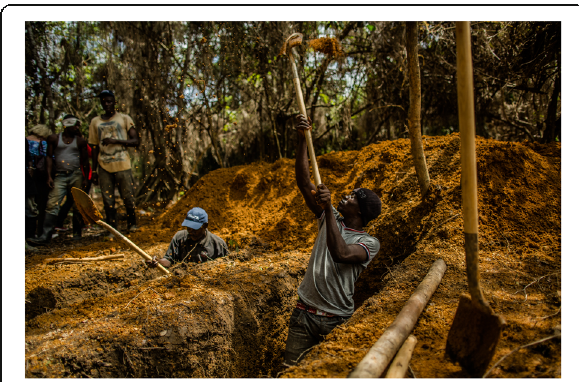
Fig. 2 Suakoko, Bong County, Liberia: workers conducting safe and dignified burials at the Bong County Ebola treatment unit. Photo